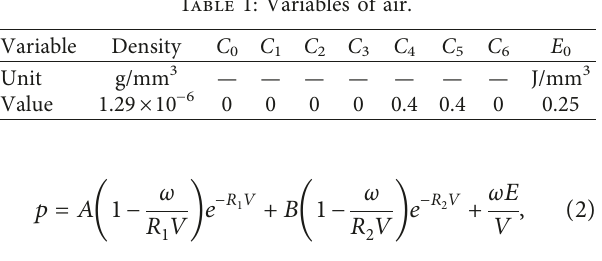
CFST confined with FRP Rigid